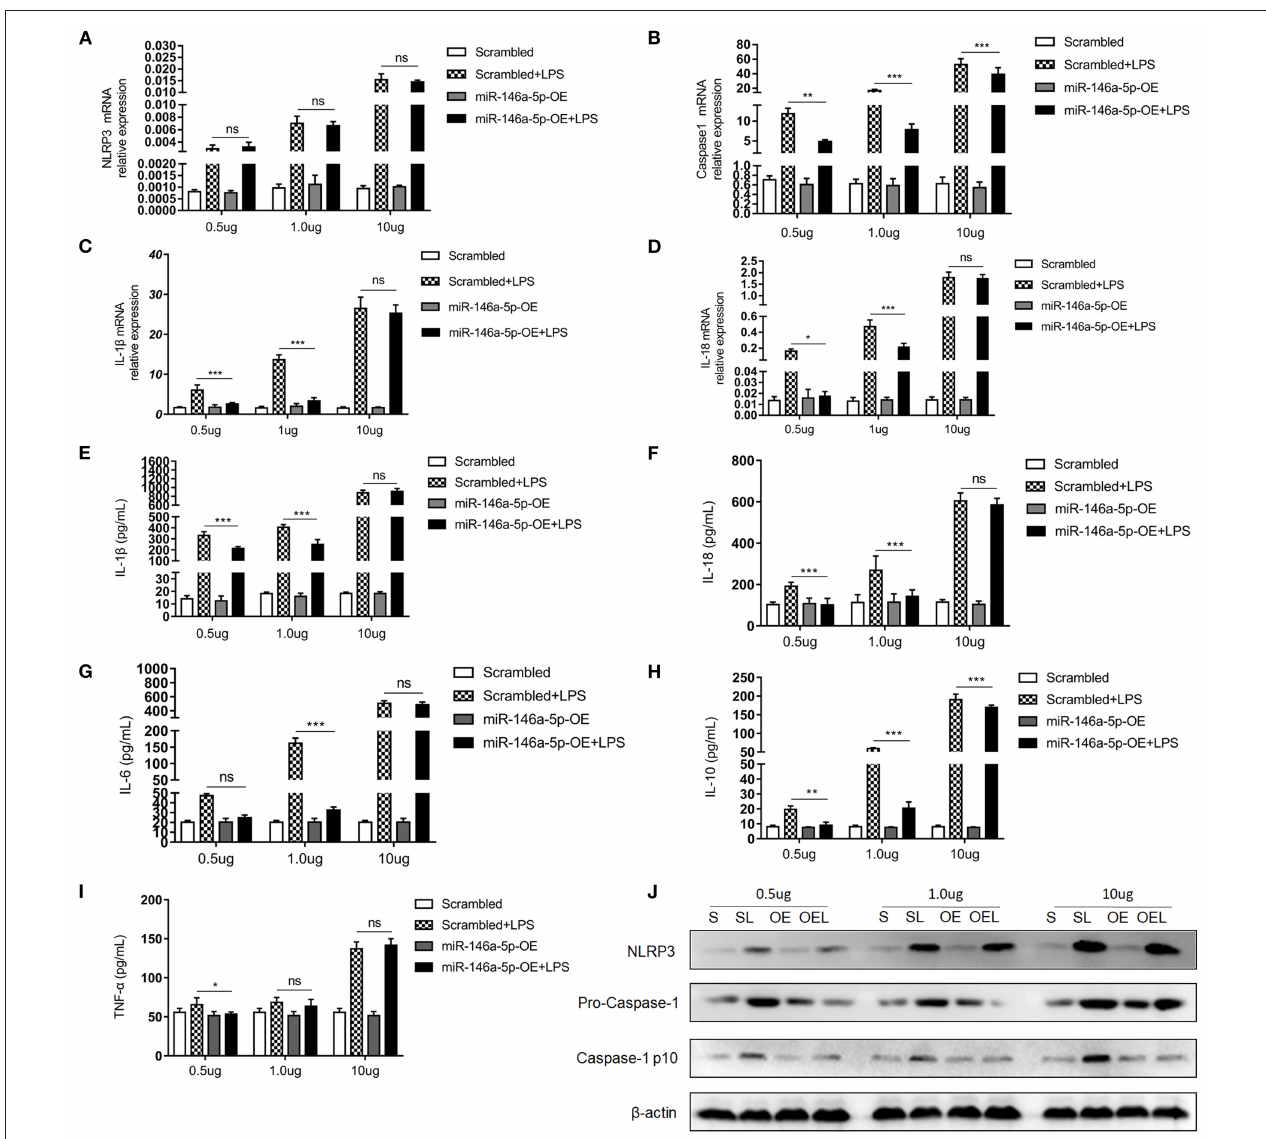
FIGURE 4 | The effect of miR-146a-5p overexpression on the NLRP3 inflammasome activation level in macrophage after LPS/ATP stimulation. (A–D) mRNA expression levels of NLRP3, Caspase-1, IL-1 β , and IL-18 after mimic preincubation followed by 0.5 µ g/ml LPS + 5mM ATP or 1.0 µ g/ml LPS + 5mM ATP or 10 µ g/ml LPS + 5mM ATP stimulation ( n = 6 per group). (E–I) ELISA showing IL-1 β , IL-18, IL6, IL-10, and TNF-a expression levels after mimic pre-incubation followed by 0.5 µ g/ml LPS + 5mM ATP or 1.0 µ g/ml LPS + 5mM ATP or 10 µ g/ml LPS + 5mM ATP stimulation ( n = 6 per group). (J) NLRP3, pro-Caspase-1, and Caspase-1 p10 protein expression levels after mimic pre-incubation followed by 0.5 µ g/ml LPS + 5mM ATP, 1.0 µ g/ml LPS + 5mM ATP, or 10 µ g/ml LPS + 5mM ATP stimulation. β -actin was re-used as the control image. Scrambled (S), miR-146a-5p scrambled sequence; Scrambled + LPS (SL), miR-146a-5p